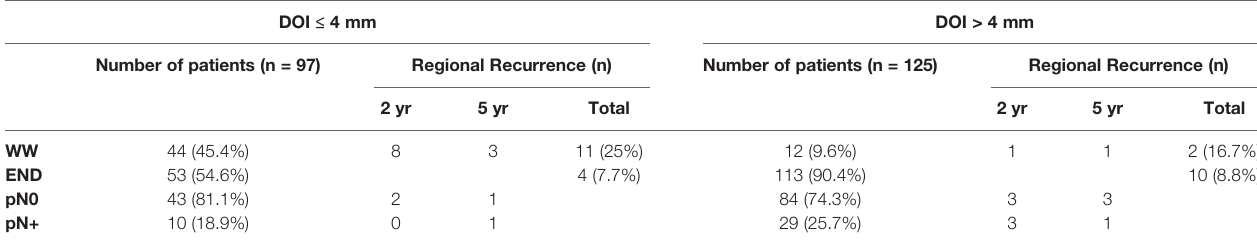
TABLE 5 | Regional recurrence for the two depth of invasion groups.